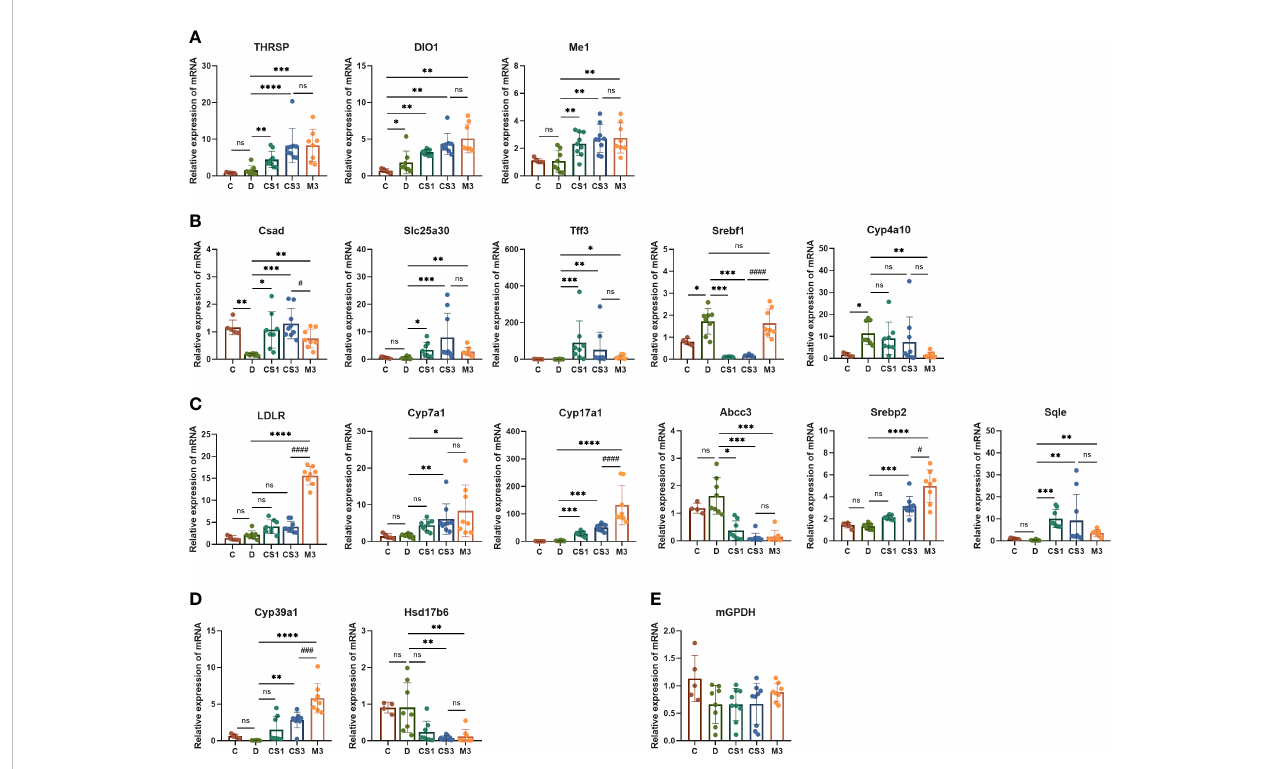
FIGURE 9 The expression of THR, hepatic and cardiac genes related to lipid and energy metabolism was validated by RT − PCR. (A) THR related genes; (B) Lipid metabolism-related genes; (C) Cholesterol metabolism-related genes; (D) Steroid metabolism-related genes; (E) Myocardial energy metabolism-related genes. All data are presented as the mean ± SD. *p < 0.05, **p < 0.01, ***p < 0.001, and ****p < 0.0001 represent data vs. DIO controls; #p < 0.05, ###p < 0.001, and ####p < 0.0001 represent MGL-3196 3 mg/kg group vs. CS271011 3 mg/kg group; ns, not signi fi cant. C, chow diet control group (n=5); D, DIO control group (n=8); CS1, CS271011 1 mg/kg group (n=9); CS3, CS271011 3 mg/kg group (n=9); M3, MGL-3196 3 mg/kg group